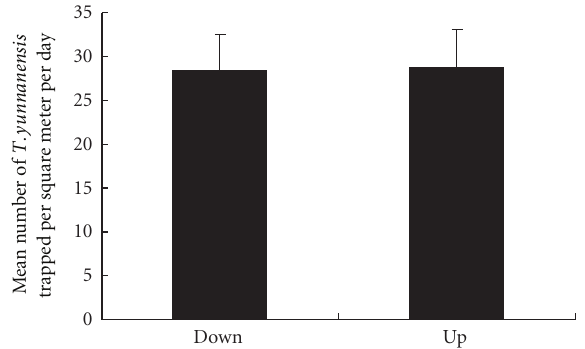
Figure 3: Daily mean trap catches ( ± SE, N = 180) of T. yunna- nensis on logs from lower-half (Down) and upper-half (Up) sections of Yunnan pines (Dec.–Feb. 2006, 2007; Qujing, Yunnan, China).